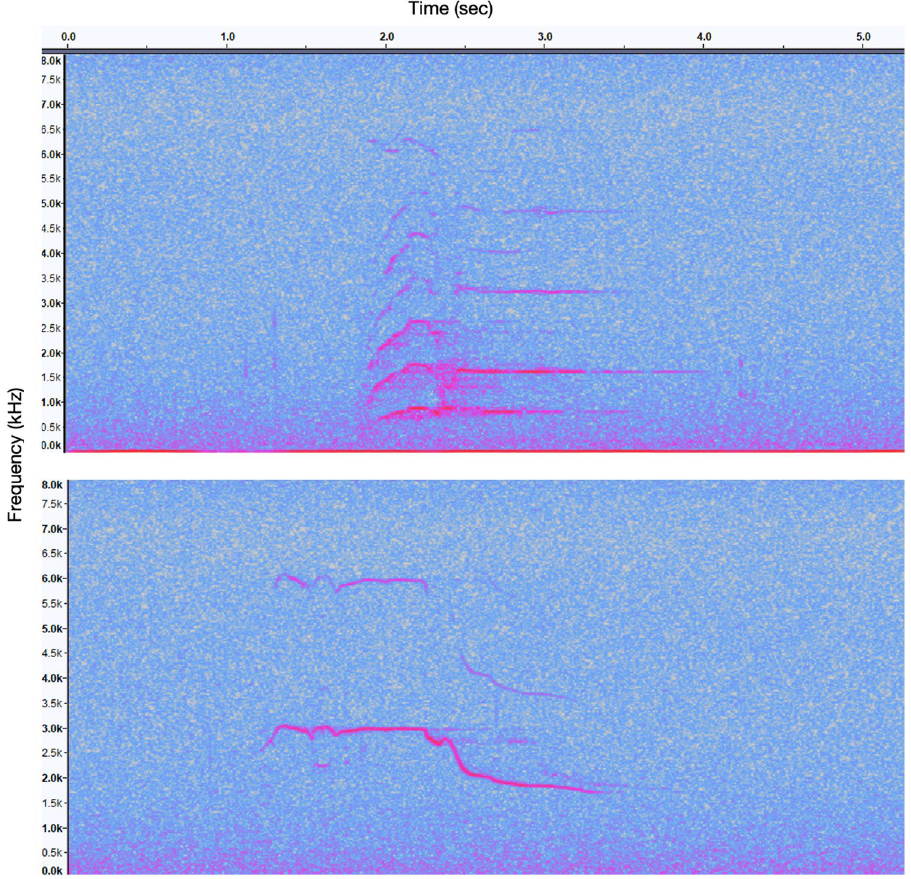
Figure 6. Example spectrograms of two discrete call types produced by Gulf of Alaska transient killer whales, GOA11 ( a ) and GOA12 ( b ) (fast Fourier transform size 1024, Hann